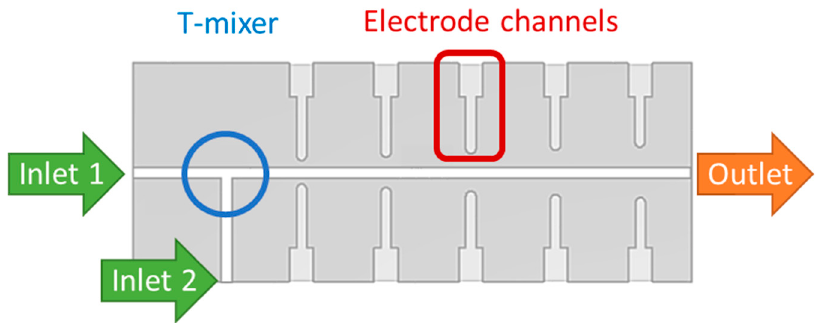
Figure 3. Electrodes along the reaction channel allow the integration of a sensor system that enables in-situ impedance spectroscopy measurements.